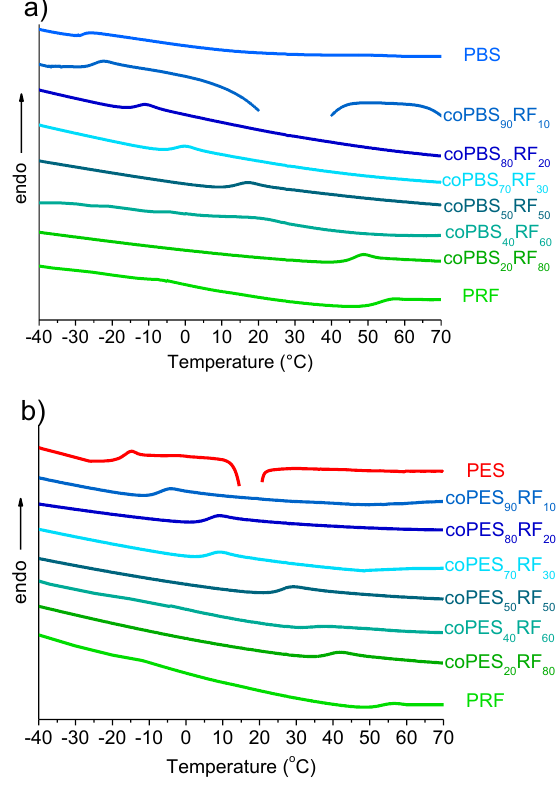
Figure 9. DSC traces showing the T g of the two series of resorcinol-containing succinate-furanoatecopolyesters, co PBS x RF y ( a ) and co PES x RF y ( b ).